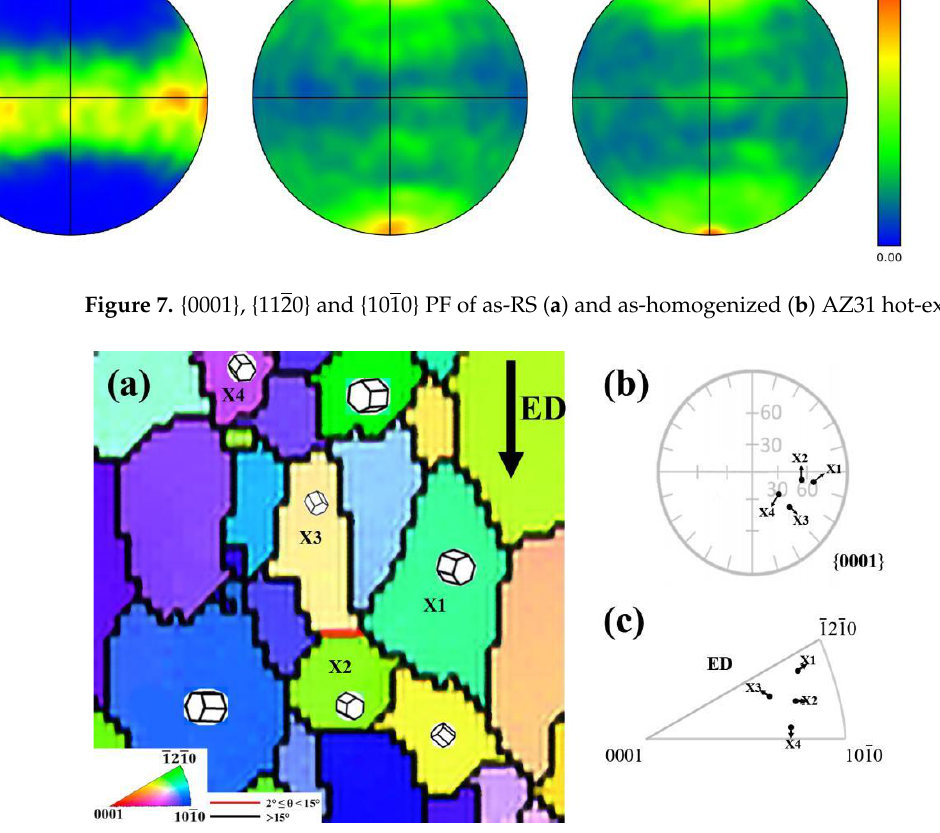
Figure 8. Specific crystallographic direction of the grains (X1, X2, X3, and X4) with < 112̅1 /< 202̅1 texture component. ( a ) IPF map; ( b ) {0001} PF; ( c ) ED IPF. texture component. ( a ) IPF map; ( b ) {0001} PF; ( c ) ED